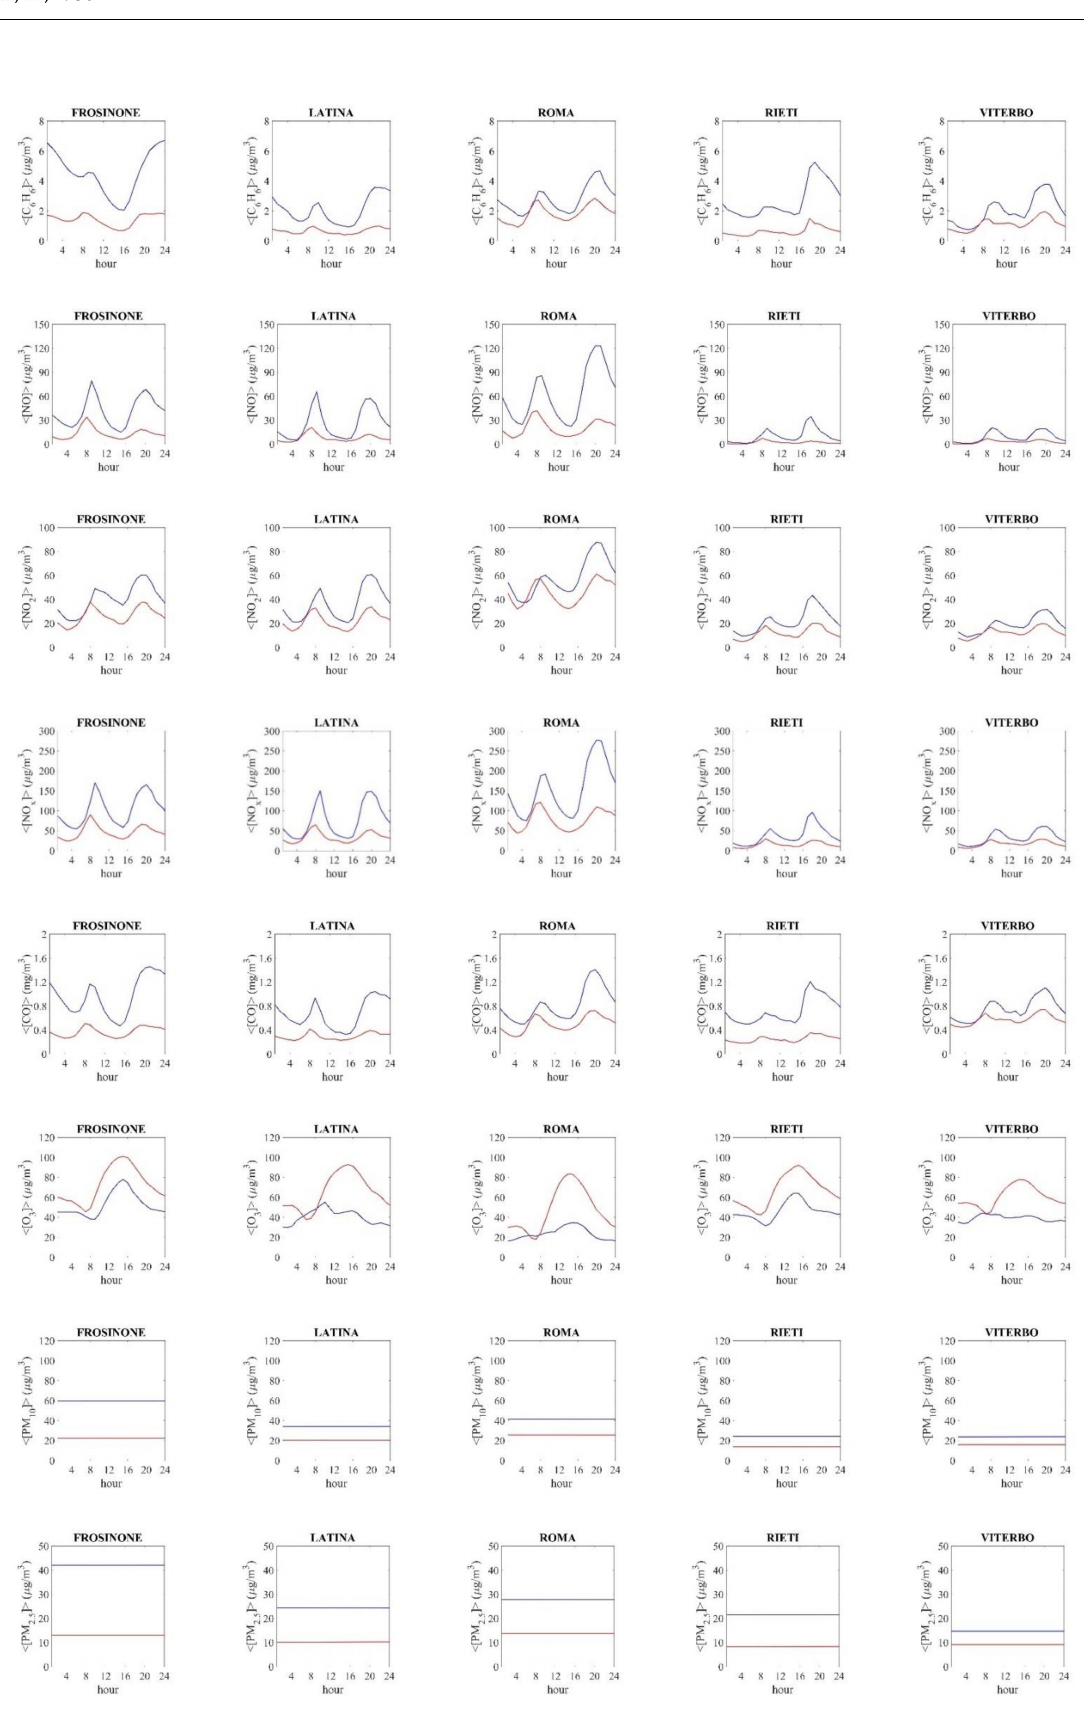
Figure 4. Day variation of pollutant during 2015 considering the mean value hour per hour and divided from winter (blue line) to spring-autumn (red